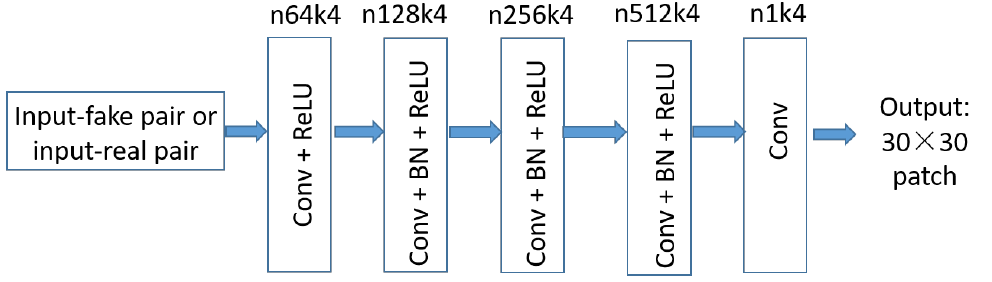
Figure 4. Illustration of the discriminative